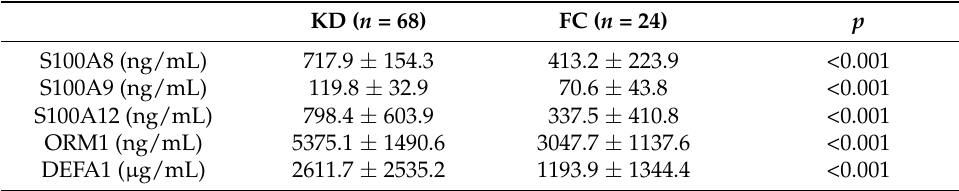
Table 3. Five selected candidate proteins in the KD patients and FC subjects.